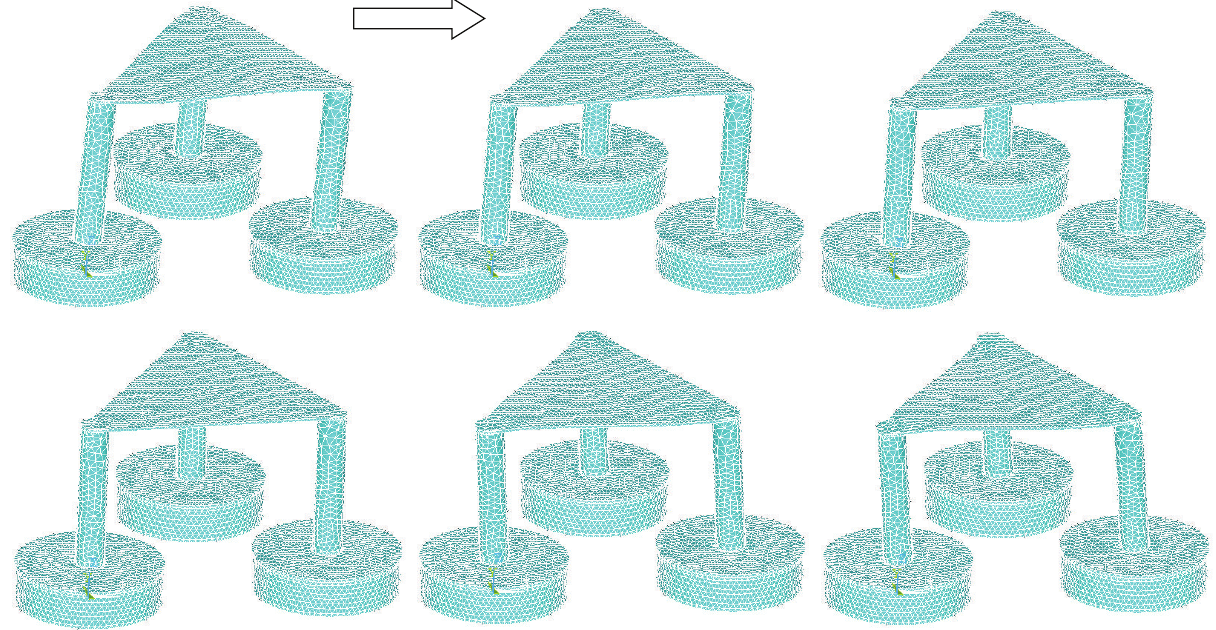
Figure 13: First modal